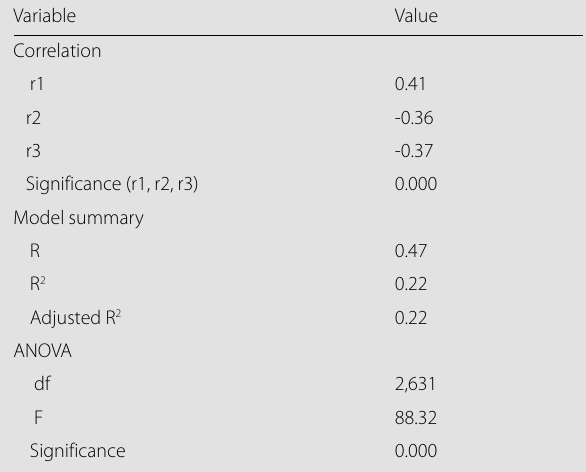
Table II. Regression analysis with psychopathology as dependent vari- able and ESS and sleep duration as independent variables Variable